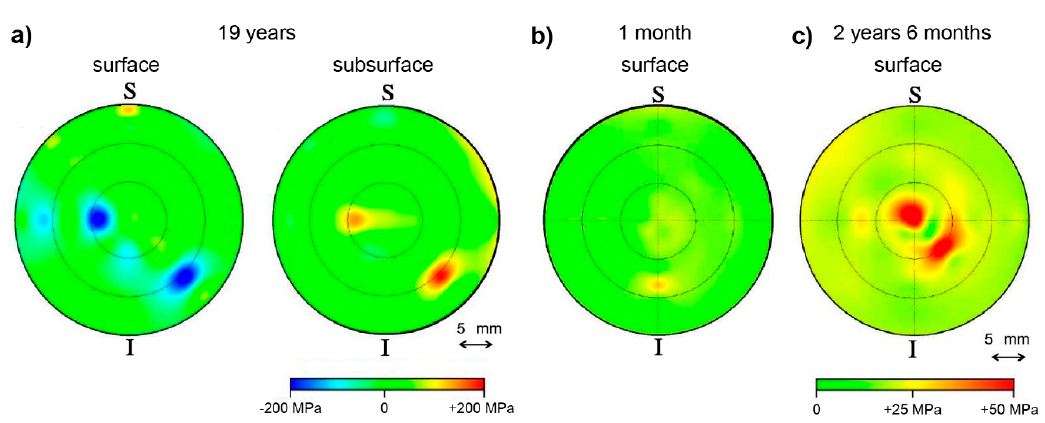
Figure 12. Stress patterns collected from implant femoral heads for ( a ) the sample exposed for the longest time in vivo and ( b, c ) samples exposed for short periods of time, one month and two years and six months, respectively. Letters S and I indicate the superior and the inferior locations of the joint during in vivo implantation. Figure adapted with permission from [85].